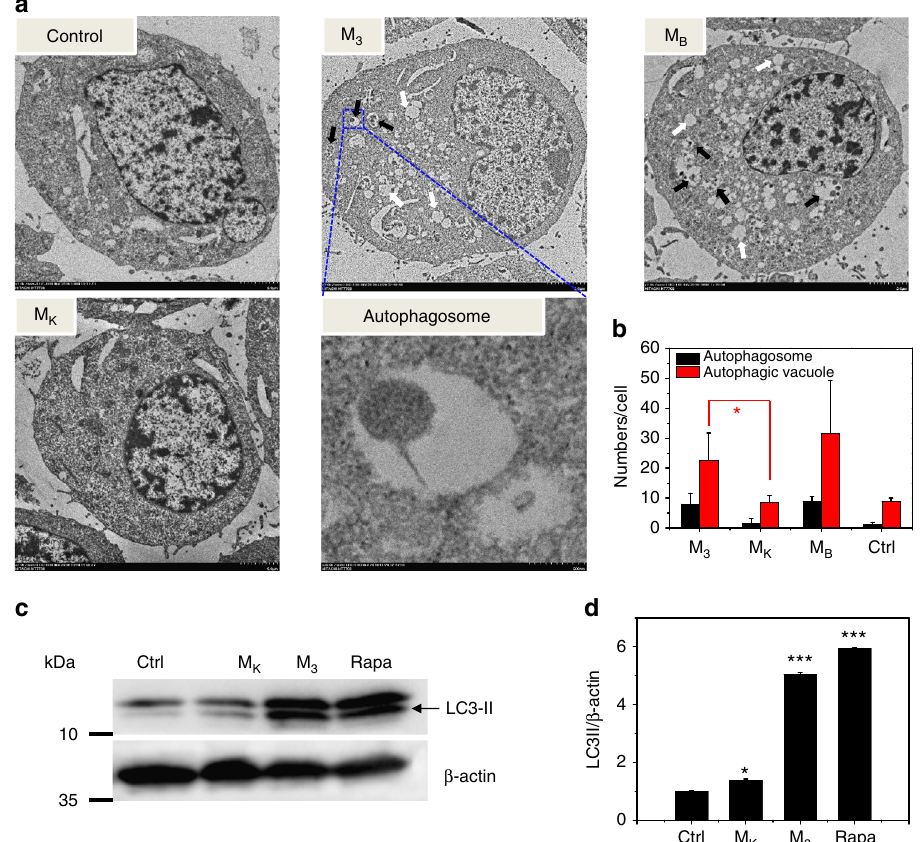
Fig. 5 M 3 activated autophagy signi fi cantly in vitro. a TEM images of N2a cells. The N2a cells were treated with PBS (control), M K (200 μ g/mL) and M 3 (200 μ g/mL), and M B (200 μ g/mL). The autophagic structures are indicated by black arrows (autophagosome), and white arrows (autophagic vacuoles). b The static results of autophagic structures were obtained from three random TEM images. Data are presented as mean ± s.d. ( n = 3). c Western blot of LC3-II and ( d ) the corresponding quanti fi ed results. N2a cells were treated for 24 h with PBS (control), M K (200 μ g/mL), M 3 (200 μ g/mL), and Rapa (1 μ M). Data are presented as mean ± s.d. ( n = 3). Statistical signi fi cance is indicated as * p < 0.05, ** p < 0.01, and *** p < 0.001, for comparison with